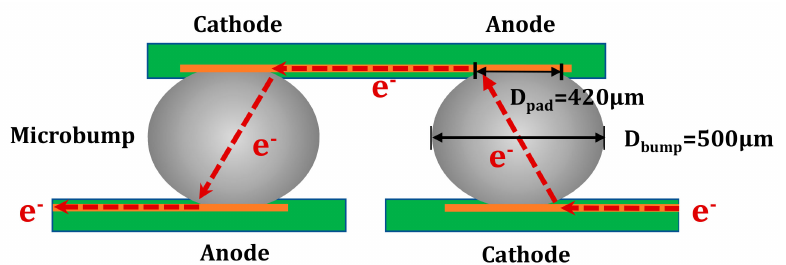
Figure 1. Cross-sectional schematic map of a piece of solder sandwiched between two chips having Au / Ni / Cu / trilayer